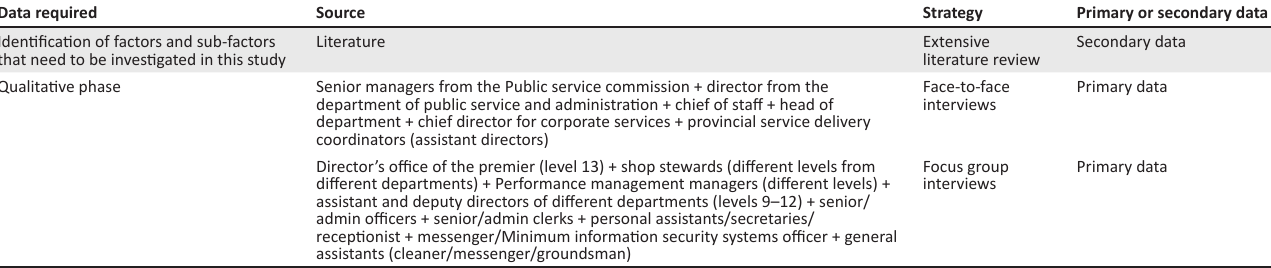
TABLE 1: Summary of qualitative data collection sources and strategies used.